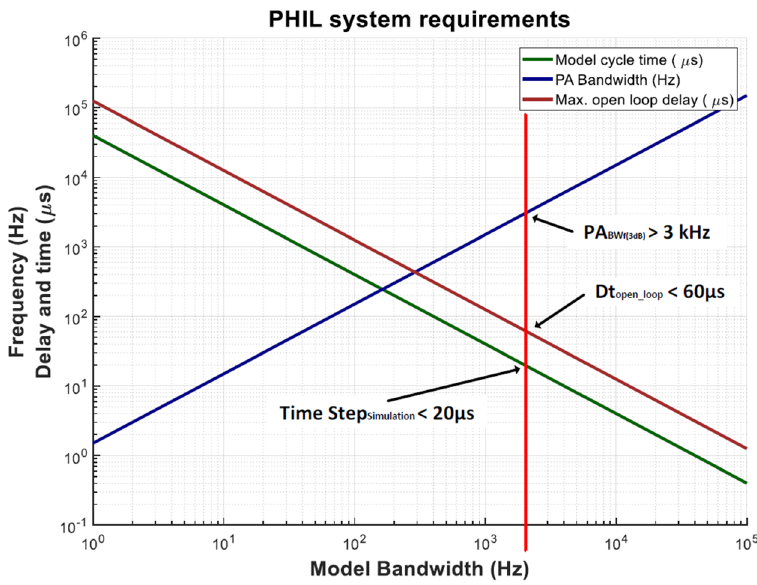
Figure 11. PHIL system requirements depending on the bandwidth of the model being tested according to [107]. In this example, a grid transient is being tested where the maximum frequency of interest is 2 kHz. Copyright permission request from [52].